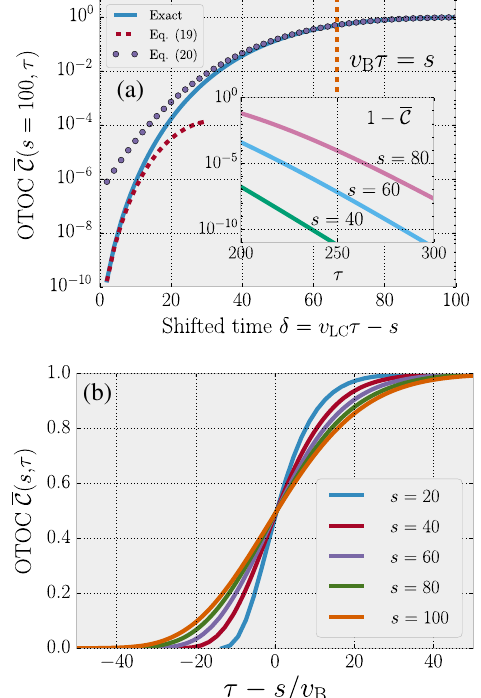
FIG. 3. Time dependence of the average OTOC in the random circuit model. (a) Different time regimes for fixed separation s ¼ 100 . The exact result for the OTOC follows Eq. (19) after the light cone hits site s . The behavior then goes over to the regime described by Eq (20) after the front with speed v inset shows the exponential decay of the OTOC to its final value 1, as described by Eq. (21), for different separations. (b) Scaling collapse of the OTOC at the